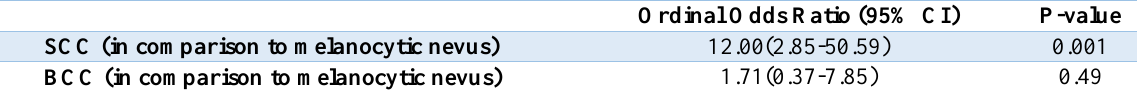
Table 3. Logistic regression analysis of each group regarding to p53 clone typing SCC (in comparison to melanocytic nevus)